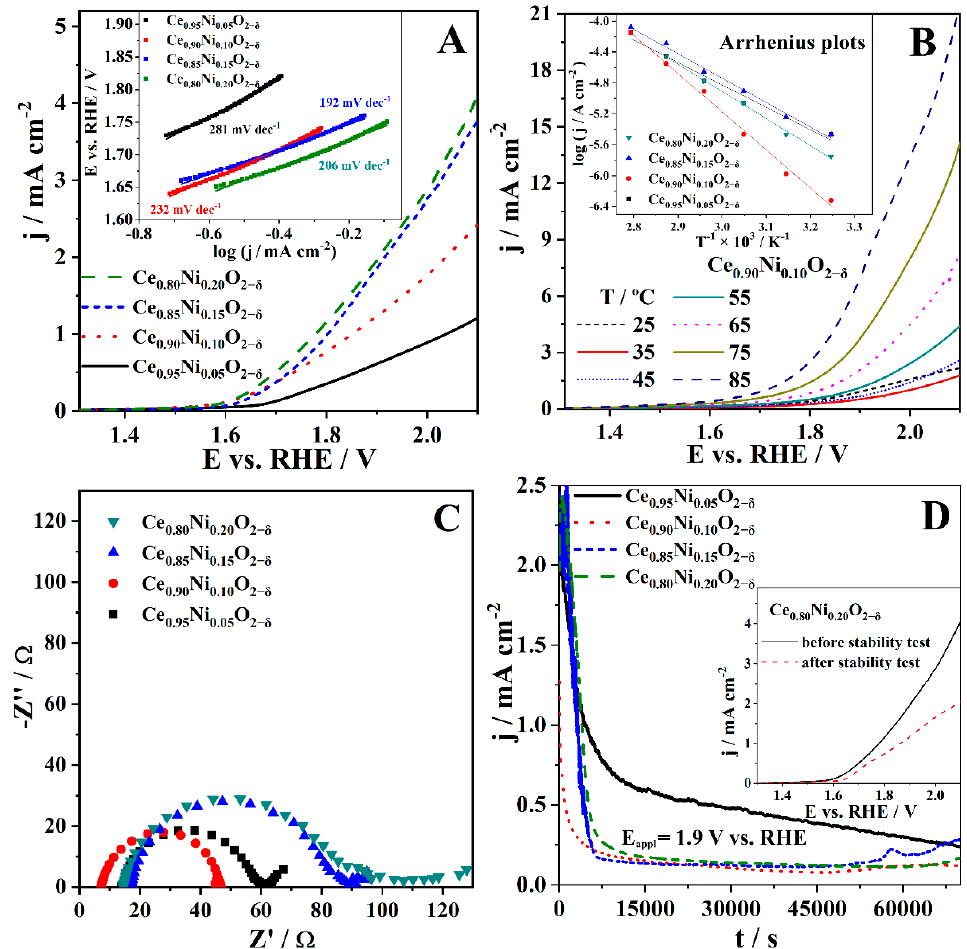
Figure 4. ( A ) RDE LSVs of the four studied Ce 1 − x Ni x O 2 − δ electrocatalysts at 10 mV s − 1 with corresponding Tafel slopes in inset. ( B ) Effect of temperature on the LSVs of Ce 0.90 Ni 0.10 O 2 − δ at 10 mV s − 1 in the 25–85 ◦ C range with the Arrhenius plots of the four electrocatalysts in inset. ( C ) Nyquist plots of Ce 1 − x Ni x O 2 − δ electrocatalysts at 2.2 V. ( D ) Chronoamperometric measurements at 1.9 V with LSVs recorded before and after the CA study in inset. Potential values are corrected for the ohmic drop in the electrolyte. All measurements performed in 0.1 M KOH electrolyte solution and 25 ◦ C, unless otherwise